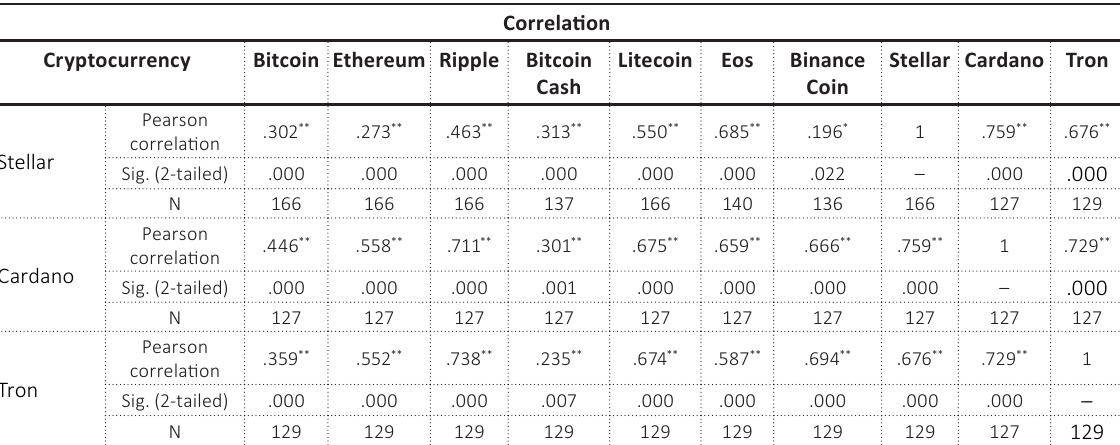
Table 5. (cont.) Pearson correlation coefficients between cryptocurrency pairs for the entire period (weekly return)